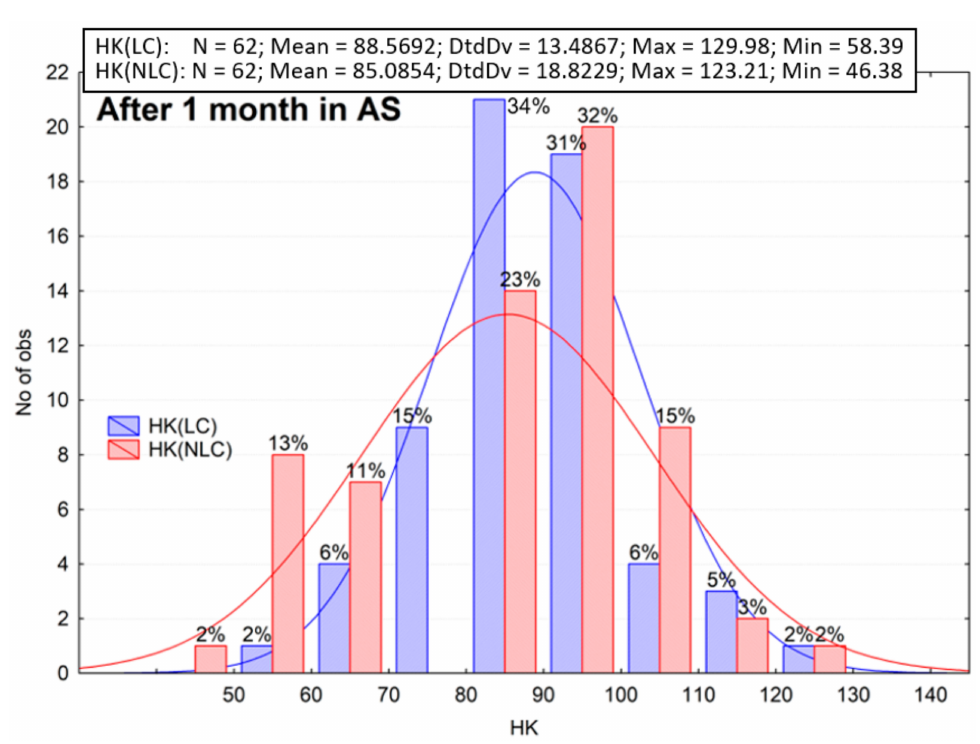
Figure 3. The results of Knoop hardness measurements for Z550 after aging in artificial saliva (AS) for one month. LC—light-cured surface of sample (top side of sample), NLC—non-light-cured surface (bottom side of sample), HK—Knoop hardness.